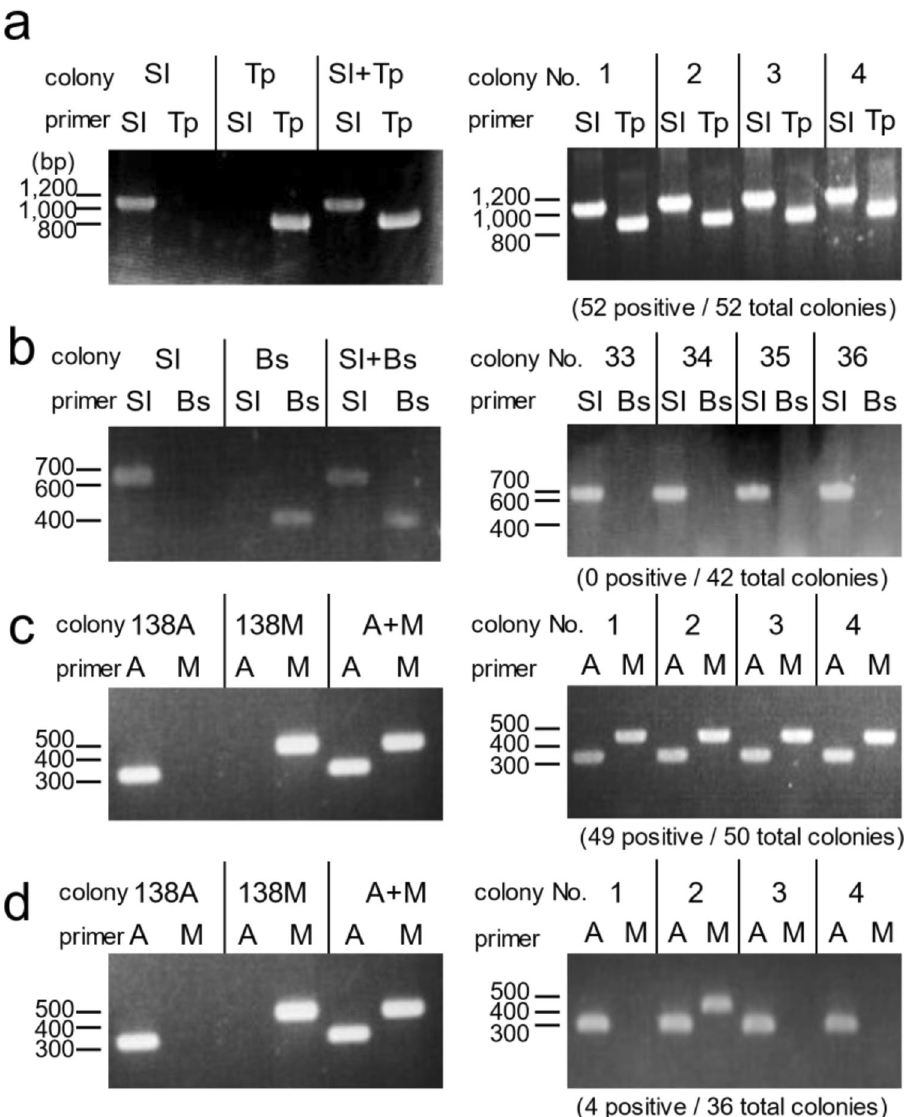
Figure 6. Detection of strains in co-isolated colony by selective PCR. Left side gel images are positive controls using a mixture of both cultures. Right side gel images are the results of colony PCR (all results are shown in Supplemental Figs. 1–4) ( a ) Selective colony PCR for detection of Streptomyces lividans (Sl) and Tsukamurella pulmonis (Tp) in isolated colonies. Colonies containing Tp/total colonies = 52/52 (100%). Original gel images are presented in Supplementary Fig. 4. ( b ) Selective colony PCR for detection of S. lividans (Sl) and B. subtilis (Bs) in isolated colonies. Colonies containing Tp/total colonies = 0/42 (0%). Original gel images are